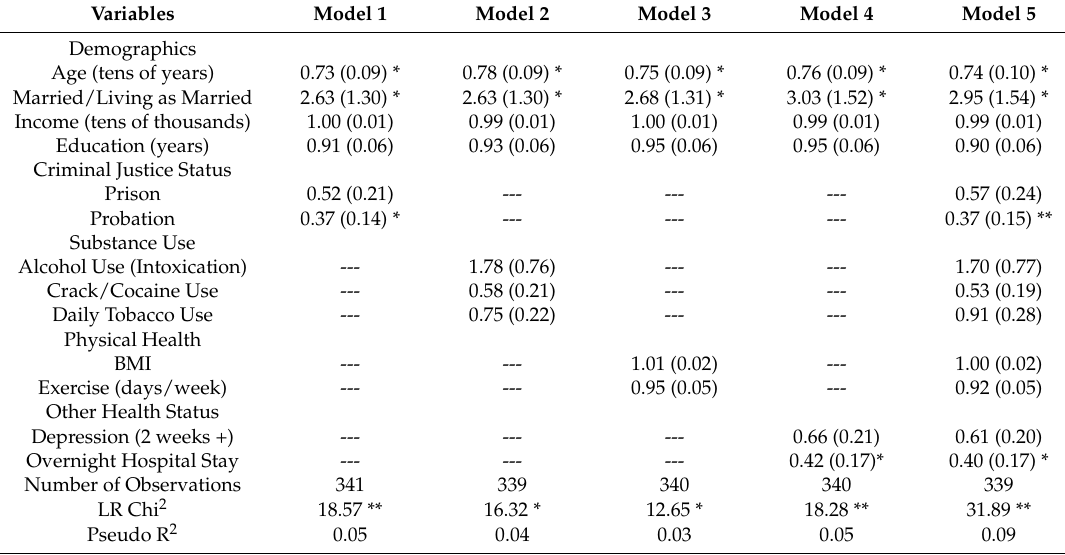
Table 6. Logistic regression predicting discussant in health matters network at follow-up with baseline demographic and health status/behavior